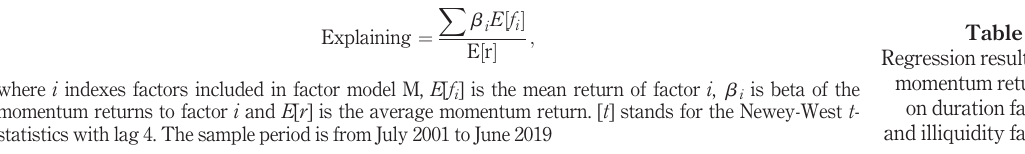
Table 10. Regression results of momentum